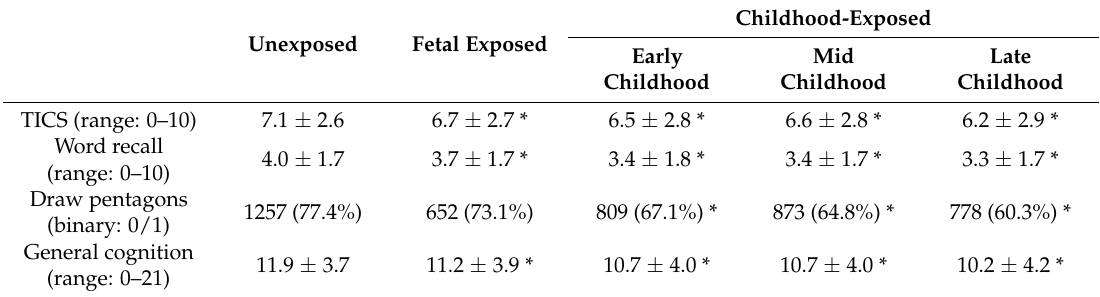
Table 2. Performance of cognitive measures in five Chinese famine-exposed groups. Unexposed Fetal Exposed